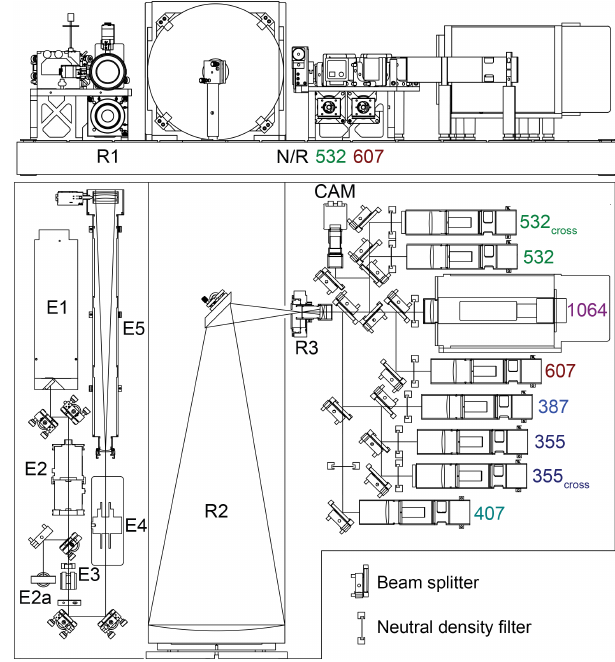
Figure 3. The optical setup of Polly XT _OCEANET. The upper part displays a top view and the lower part the front view of the system. Details are explained in the